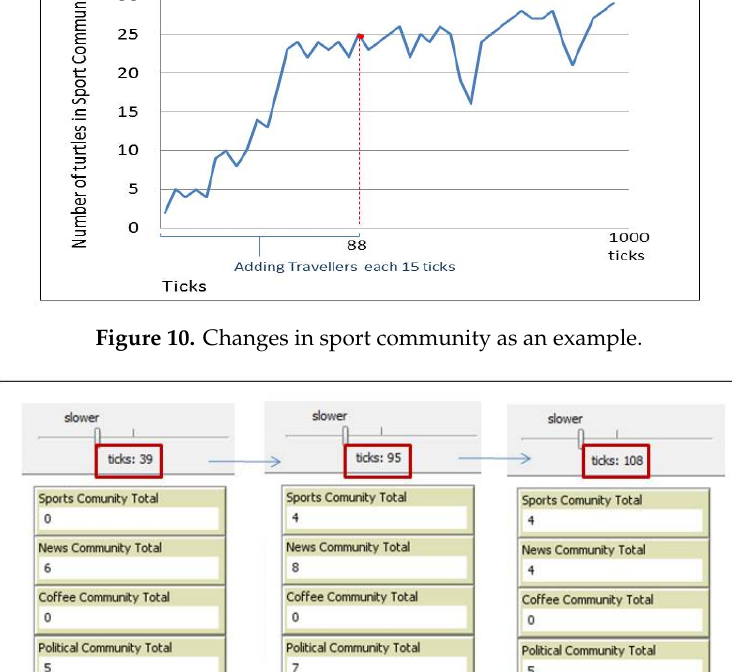
Figure 9. Number of objects in different communities over a period of time.